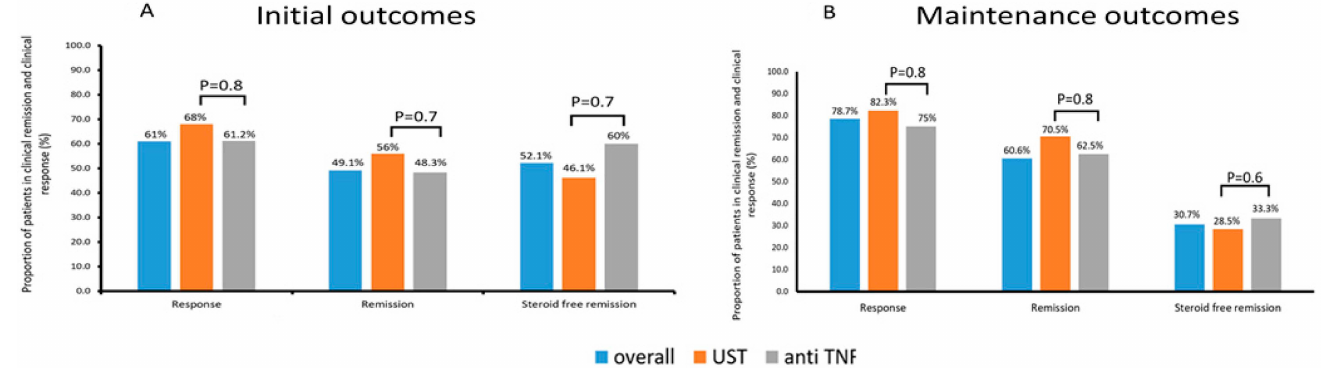
Figure 2. Outcomes in the initial ( A ) and maintenance period ( B ). The proportion of patients achieving clinical remission (HBI ≤ 4), clinical response (delta HBI ≥ 3) and steroid-free remission